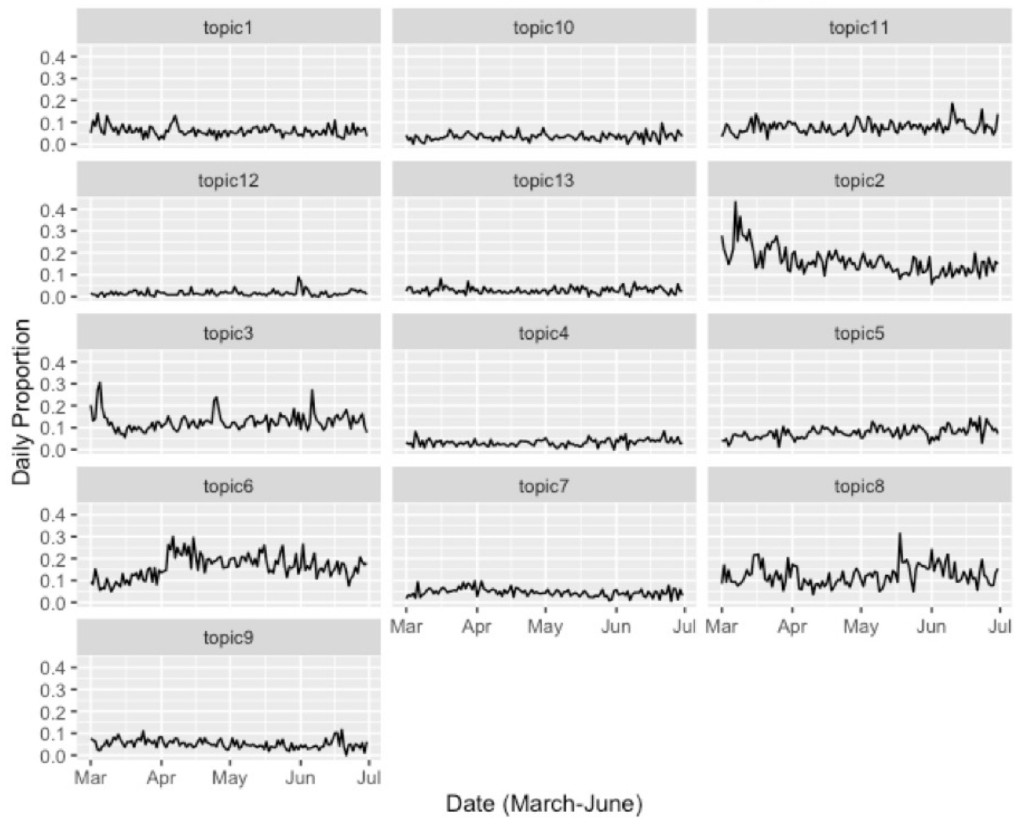
Fig 4. Overtime trend in daily relative volume by topics. Topic1 = monetary motivation, Topic 2 = infectious disease, Topic 3 = safety concern, Topic 4 = vaccine information, Topic 5 = new normal, Topic 6 = conspiracy, Topic 7 = consolidation, topic 8 = vaccine development, Topic 9 = inherent uncertainty, Topic 10 = vaccine effectiveness, Topic 11 = clinical trial, Topic 12 = coping strategies, Topic 13 = vaccine production.